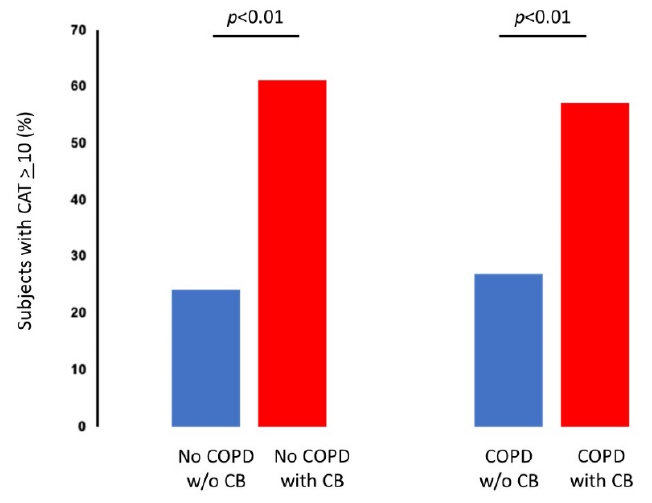
Figure 2. Effects of Chronic Bronchitis (CB) on the COPD Assessment Test (CAT score). The pres- ence of CB increased the percentage of subjects with abnormal CAT score (CAT ≥ 10) both in smok- ers with and without COPD. COPD: Chronic Obstructive Pulmonary Disease; CAT: COPD Assess- ment